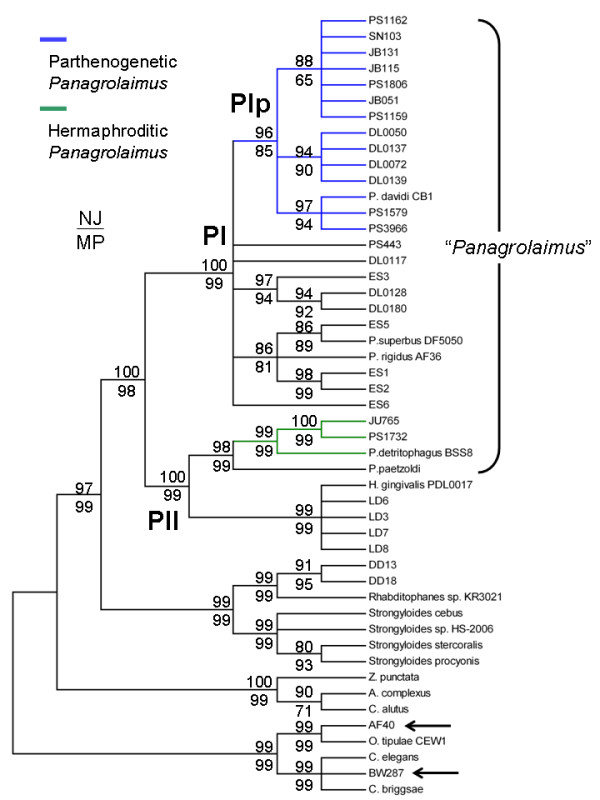
Nuclear rRNA gene phylogeny for Panagrolaimus. Cladogram shown is a 80% bootstrap consensus tree for NJ analysis of aligned 18S and 28S rRNA sequences from Panagrolaimus and select outgroup nematode species and strains. The MP phylogeny was highly congruent with the NJ phylogeny shown – see Additional files 1 and 2. Node-specific bootstrap values (1,000 replicates for each analysis) are shown, with NJ values over MP values. All strains and species historically considered as members of the Panagrolaimus genus are indicated by the brackets. Arrows denote the positions of two rhabditid strains initially misidentified as Panagrolaimus. Blue lines indicate parthenogenetic strains and green lines indicate hermaphroditic strains of Panagrolaimus. H. gingivalis also reproduces parthenogenetically in infected horses. DD13 and DD18 are two strains isolated from Newport, OR USA that are closely related to Rhabditophanes sp. KR3021. All other outgroup sequences were retrieved from Genbank.